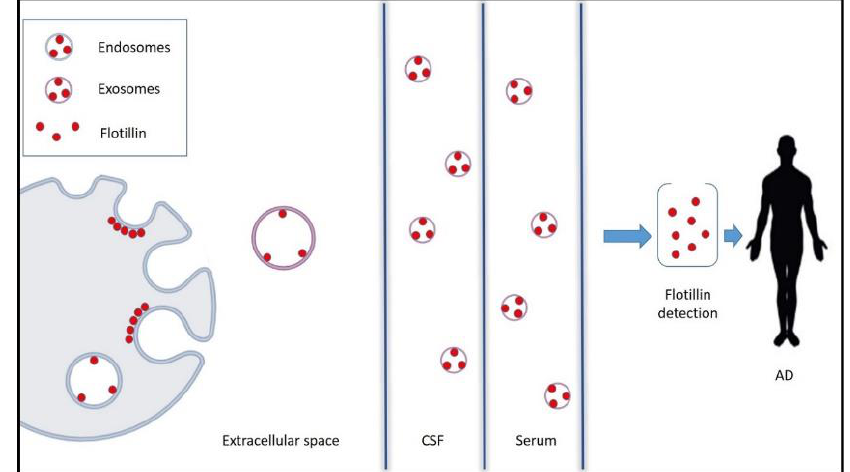
Figure 1. Lipid rafts, endosomes, and exosomes are enriched in flotillin.